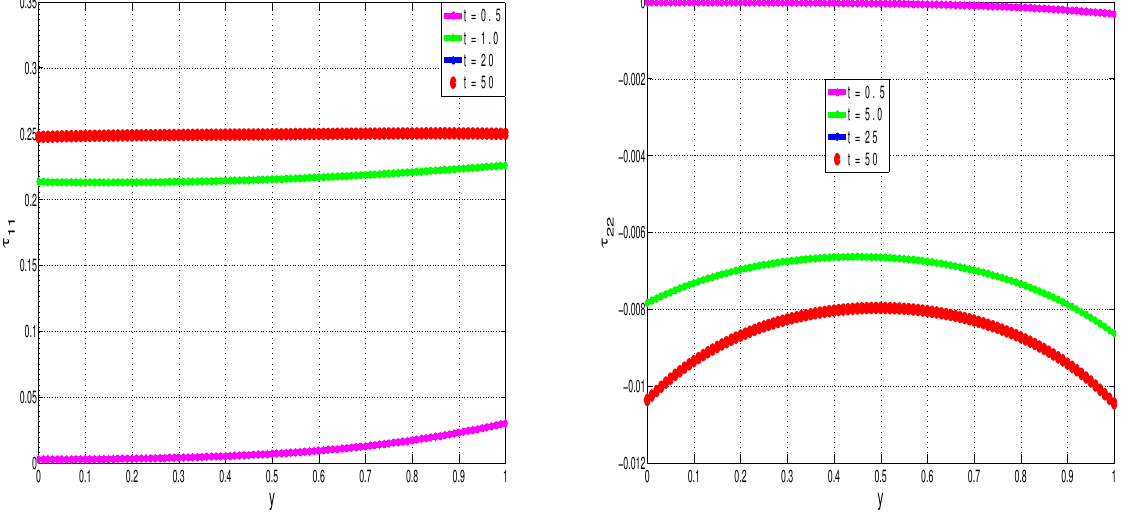
Figure 3. Development of steady polymer stress profiles; τ 11 -stress ( left ) and τ 22 -stress ( right )